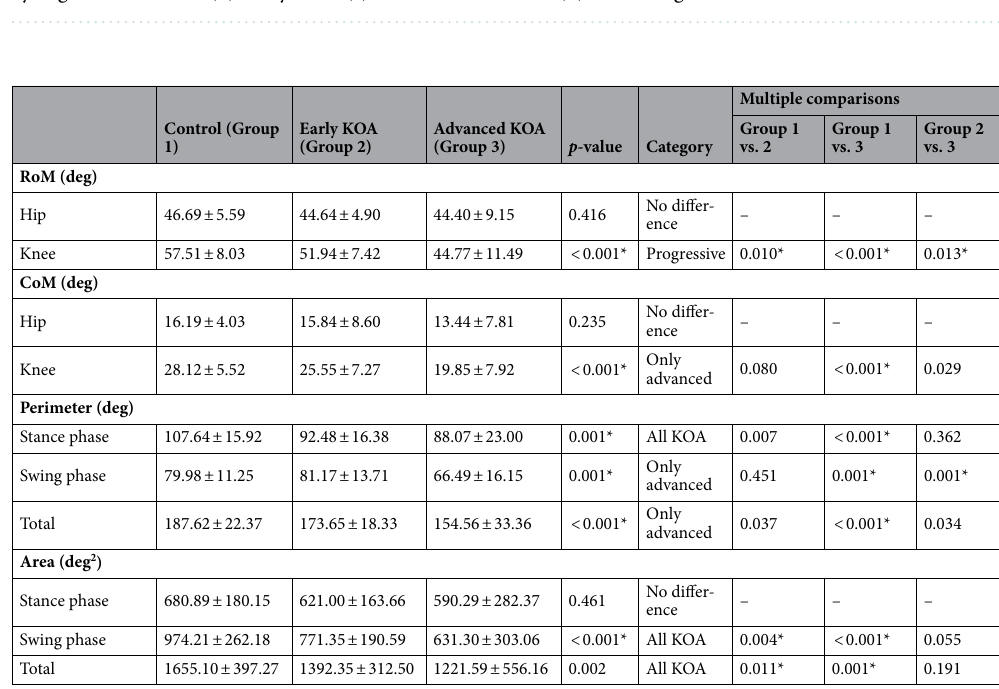
Table 2. Hip-knee cyclogram parameters between groups. Values are mean ± standard deviation. KOA knee osteoarthritis, CoM center of mass, RoM range of motion. P value by Kruskal–Wallis test and multiple statistical differences between groups by Mann–Whitney U test with Bonferroni correction. *Significant difference between groups.